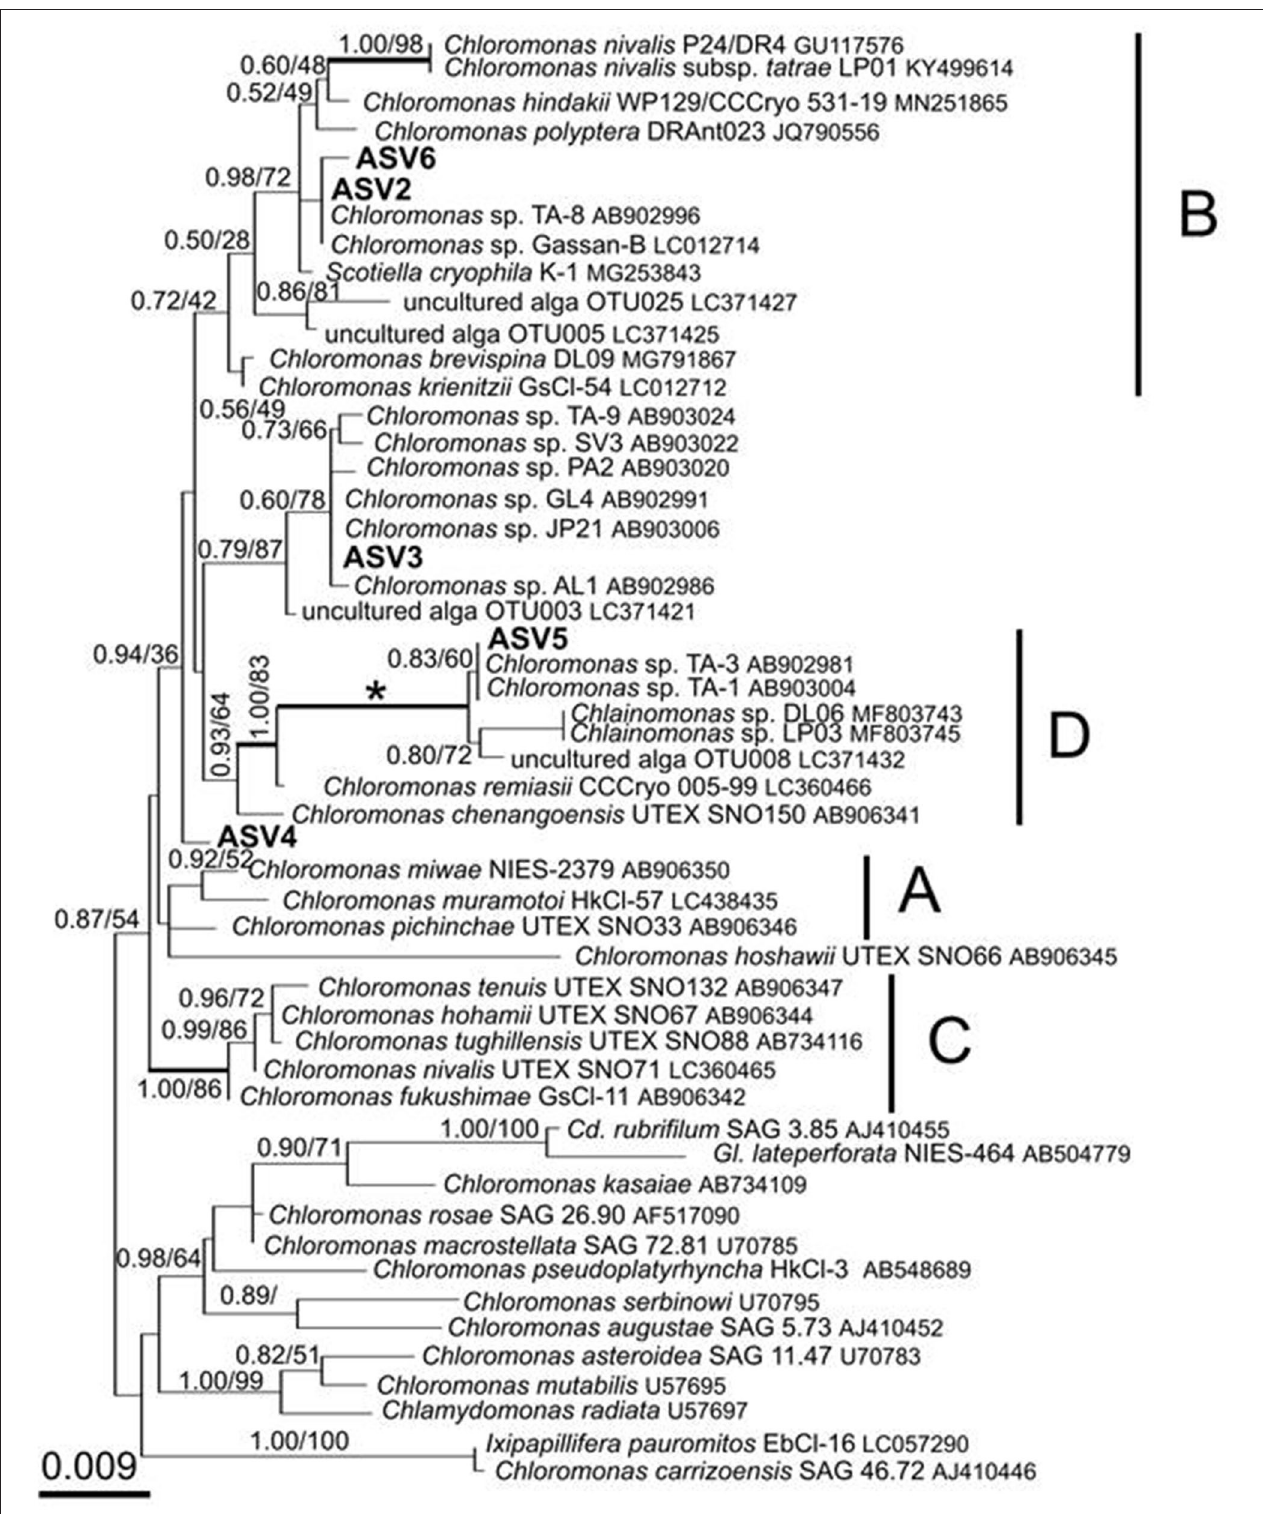
FIGURE 8 | 18S rRNA-gene-based maximum-likelihood phylogeny of snow-inhabiting Chloromonas/Chlainomonas spp. showing phylogenetic positions of the five major ASV reads (ASV2–ASV6) detected in the red snow samples in Mt. Tateyama, Japan. The labeled clades “A,” “B,” and “C” correspond to Matsuzaki et al. (2019). Posterior probabilities and bootstrap values from maximum likelihood analysis are shown. Full statistical support (1.00/100) is marked with an asterisk. Thick branches represent nodes receiving the highest posterior probability support (1.00). Accession numbers, strain, or field sample codes are indicated after each species name.